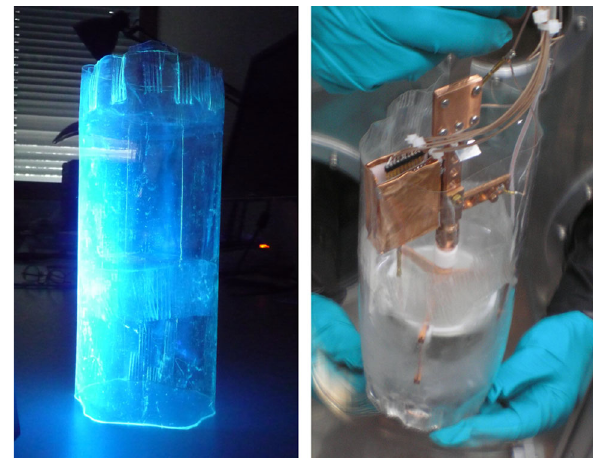
Fig. 4 Left: photo of the first version of a nylon mini-shroud coated with WLS (the photos were taken in UV light). The nylon sheets were connected by welding. Right: NMS in assembly with a bare BEGe detector inside the lock of